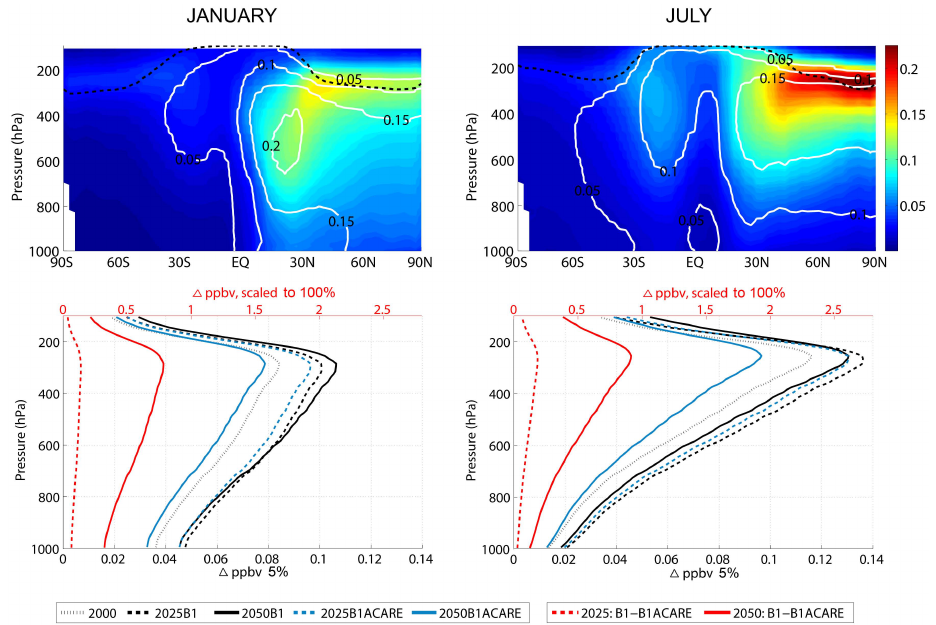
Fig. 7. Zonal mean perturbations of ozone ( 1 ppbv) during January (left) and July (right) for the 2050 B1 scenario (top) and as Northern Hemisphere average for all years (bottom). In the top figures, solid contour lines show the change relative to the BASE simulation while the dashed line indicates the tropopause. The color bar and the bottom x-axis show the unscaled impact of the 5% perturbation of aircraft emissions (simulations BASE – AIR), while the red scales in the bottom figures are scaled up by a factor 20 from 5% to 100% and refer to all lines. The red lines show the difference between the B1 and B1ACARE scenarios and refer to the red axis